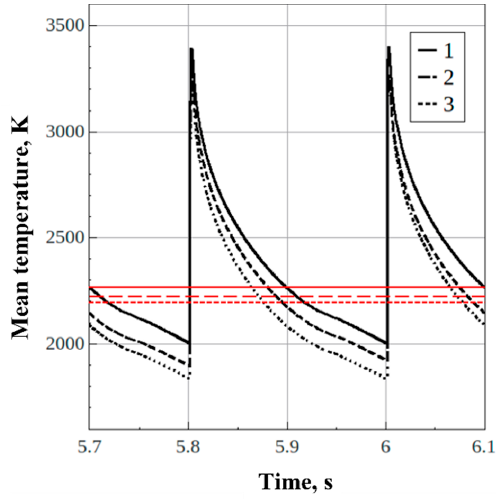
Figure 4. Calculated time histories of mean temperature in the flow reactor at pulsed detonation gun operation with a frequency of (cid:1858) = 5 Hz without waste feed ( (cid:1842) = 0.1 MPa): (cid:1846) (cid:3050) = 800 K (1), 650 operation with a frequency of f = 5 Hz without waste feed ( P = 0.1 MPa): T w = 800 K (1), 650 K (2) и K (2) и 450 K (3). 450 K